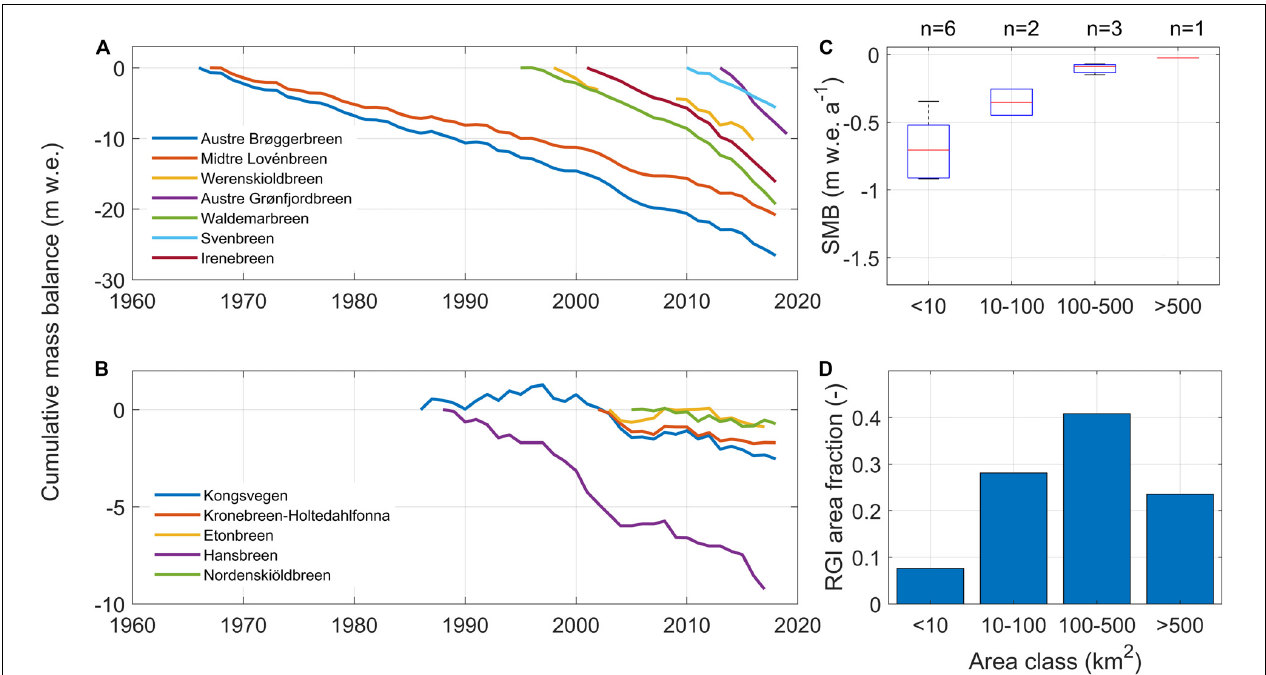
FIGURE 2 | Cumulative specific, glaciological mass balance (excluding frontal ablation) from in situ measurements at selected Svalbard glaciers, for glaciers smaller (A) and larger (B) than 50 km 2 . Note the different scaling of the y -axes. (C) Boxplots of annual specific SMB averaged over the period since 2000 for four different area classes. (D) Fractions of glacier area occupied by glaciers in respective area classes, relative to the entire glacier area, for all Svalbard glaciers in the Randolph Glacier Inventory (Pfeffer et al., 2014); n indicates the number of surveyed glaciers in each area